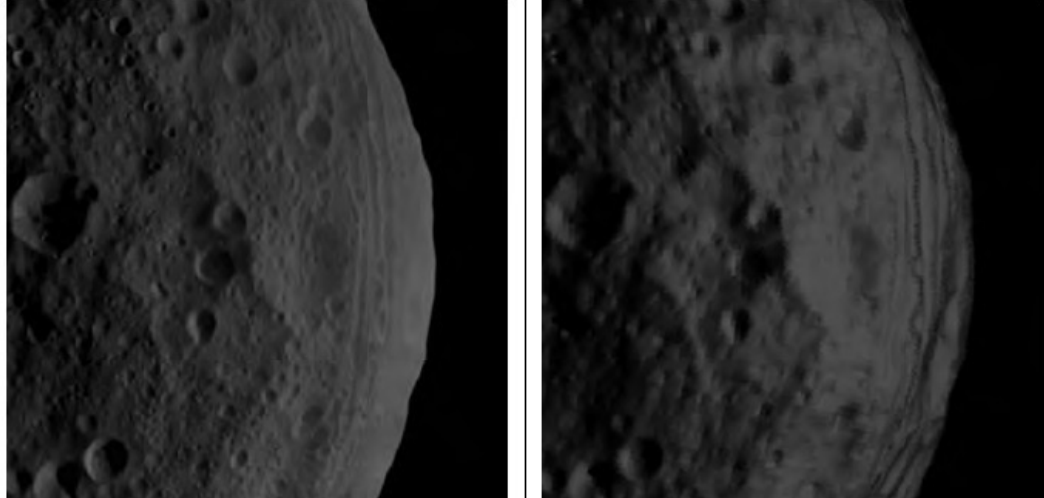
Figure 19. Left: real image as acquired by the DAWN Framing Camera FC2. Right: simulated image, 196608-triangle-model of Vesta with 1024 × 1024 px camera resolution. Image ID FC21B0005907- ≈ 0.039. 11232212051F1B.FIT , χ 2 s